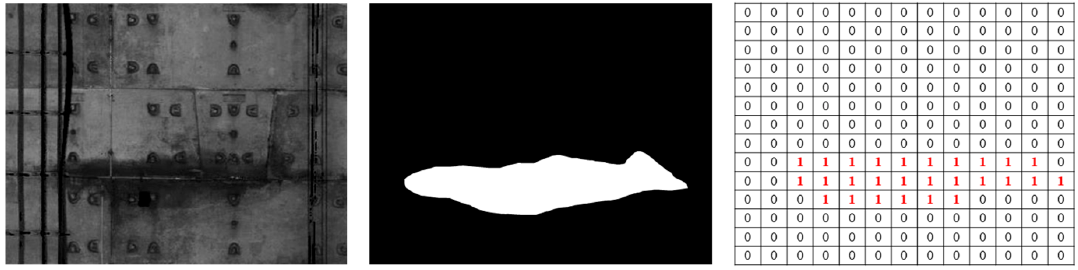
Figure 12. Illustration of the binary mask image.